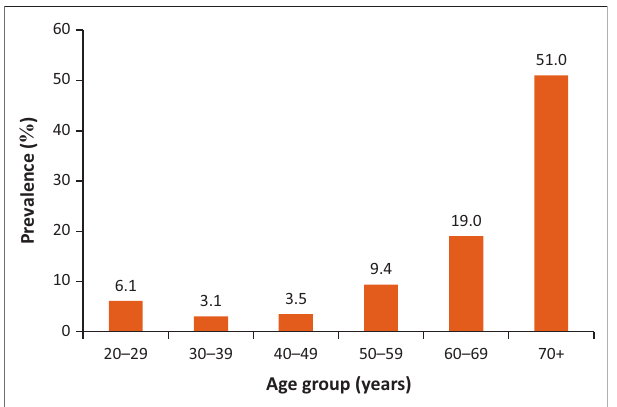
FIG URE 3: Prevalence of visual impairment by age group.